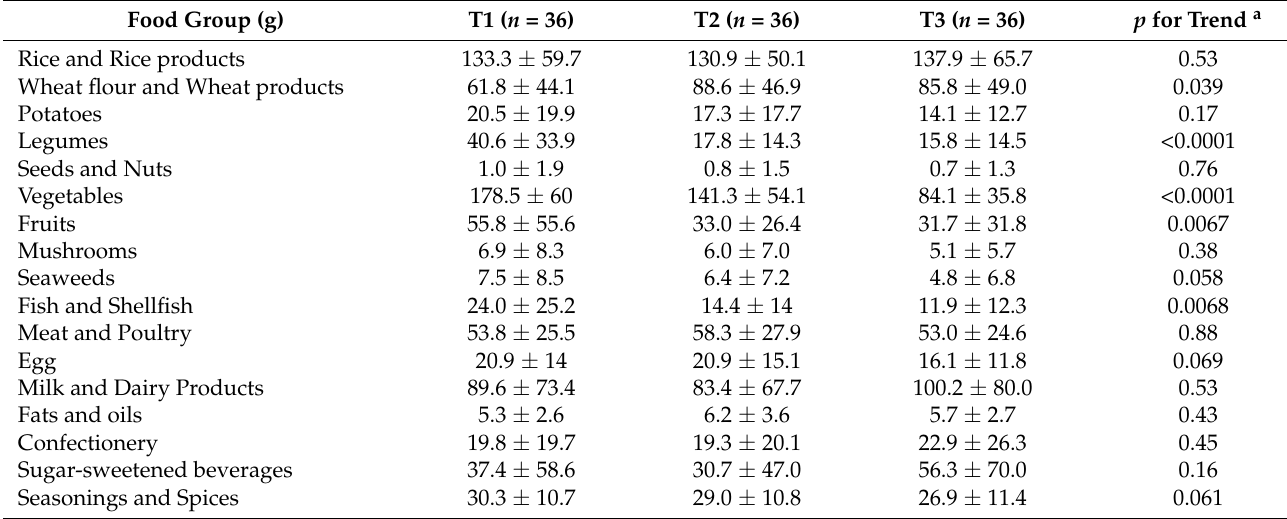
Table 3. Food group intake across the tertile (T) categories of energy-adjusted dietary inflammatory index (E-DII) in pregnant women of a birth cohort, BC-GENIST, in